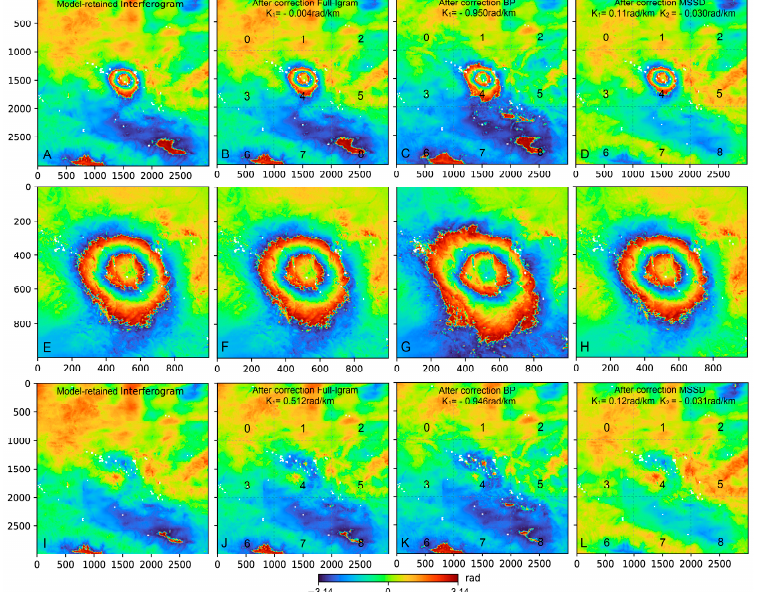
Figure 12. Comparison between the interferograms (wrapped) in the 2016 Menyuan coseismic dis-